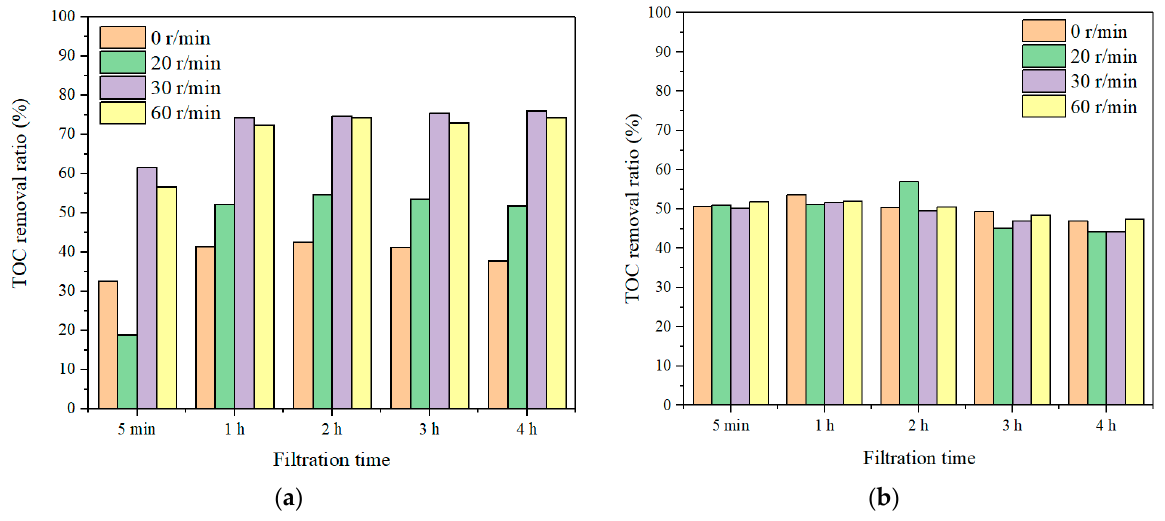
Figure 4. TOC removal ratios with different rotation speeds, ( a ) SA, and ( b ) TA. The molecular weight distribution of SA solution with both TOC detection (Figure 5) and UV detection (Figure 6) with different rotation speeds were examined. The results indicated that there were three obvious peaks for the HPSEC curve of SA, i.e., 1000–10,000 Da, 10,000–100,000 Da, and 100,000–1,000,000 Da. Since the hollow fiber membrane has an MWCO of 150,000 Da, it could remove part of the macro molecules with a molecular weight of 100,000–1,000,000 Da due to the sieving effect, while with the additional rotation, the peak intensity of the macro molecules with a molecular weight of 100,000–1,000,000 Da reduced completely. This suggested that the membrane rotation was effective in removing large molecule organics. With the membrane rotation, the peak intensity of the micro molecule organic matter with molecular weight of 1000–10,000 Da only dropped slightly, which indicated that the membrane rotation could eliminate very limited small organic substances with the removal, probably due to adsorption. It can be also observed that with the increase of the rotation speeds, the peak intensities for both macro and micro molecules reduced, which suggested that the membrane rotation could intensify the removal of organ- ics. Moreover, the molecular weight distributions of the organics after membrane rotation for different permeate durations were nearly the same, thus, the membrane rotation could be effective for organics removal for long time